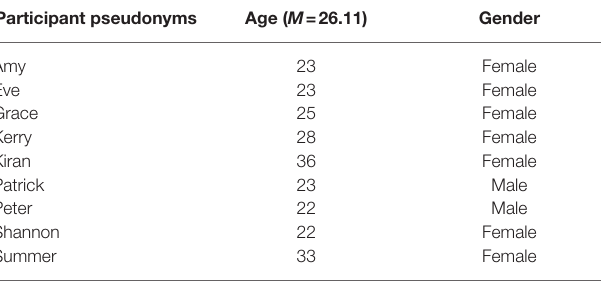
TABLE 1 | Participant demographic